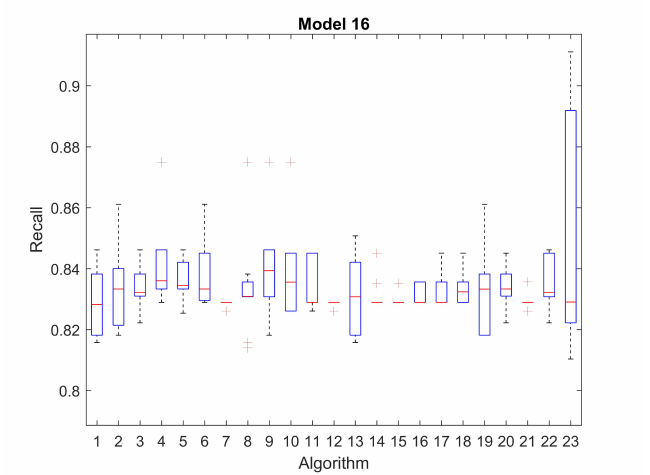
Figure A13. Recall of Model 16 for the different algorithms. The 23 algorithms are represented in the x -axis, and the accuracy is shown in the y